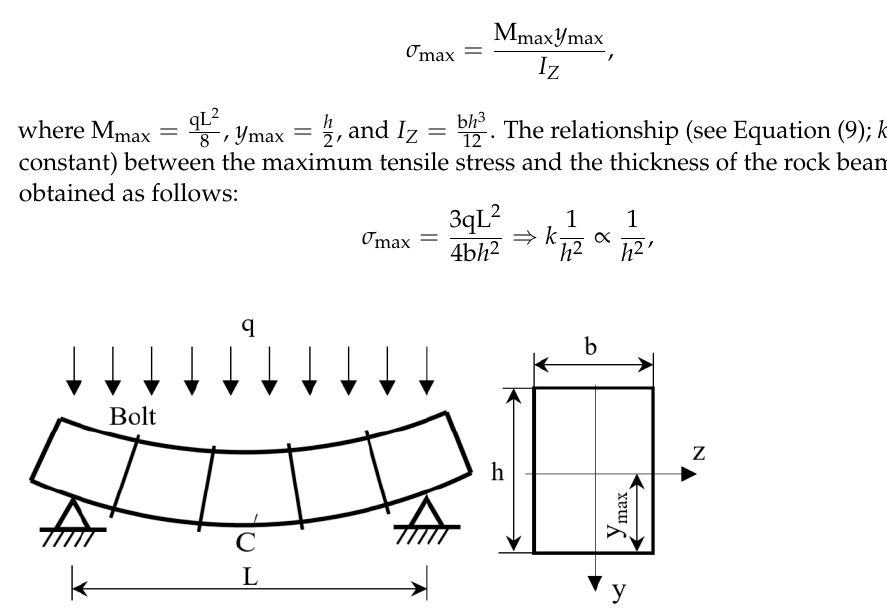
Figure 12. Mechanical model of a simply supported beam for an anchored rock beam.